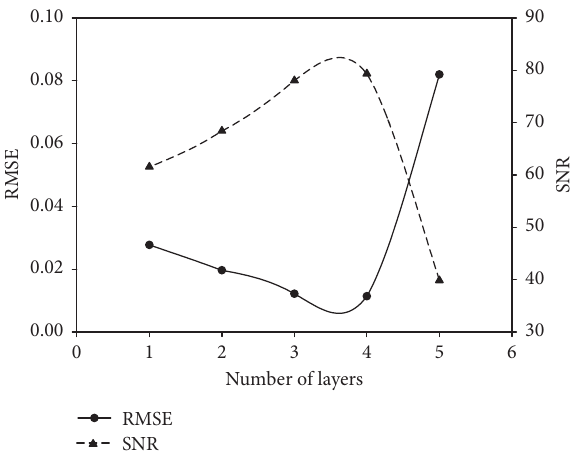
Figure 7: SNR and RMSE after denoising at different decomposition